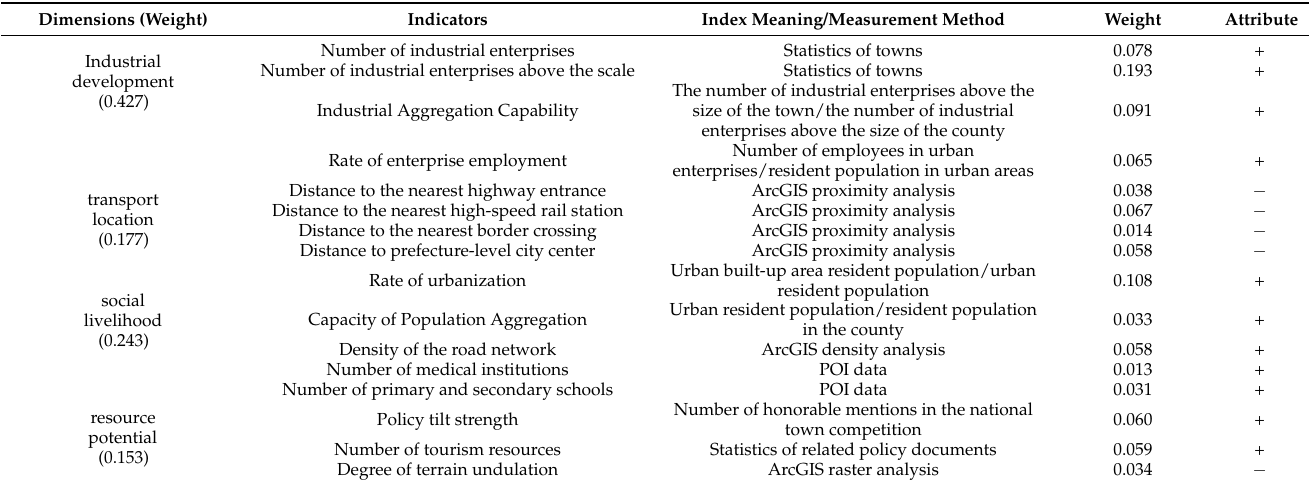
Table 2. Assessment indicators system for regional small